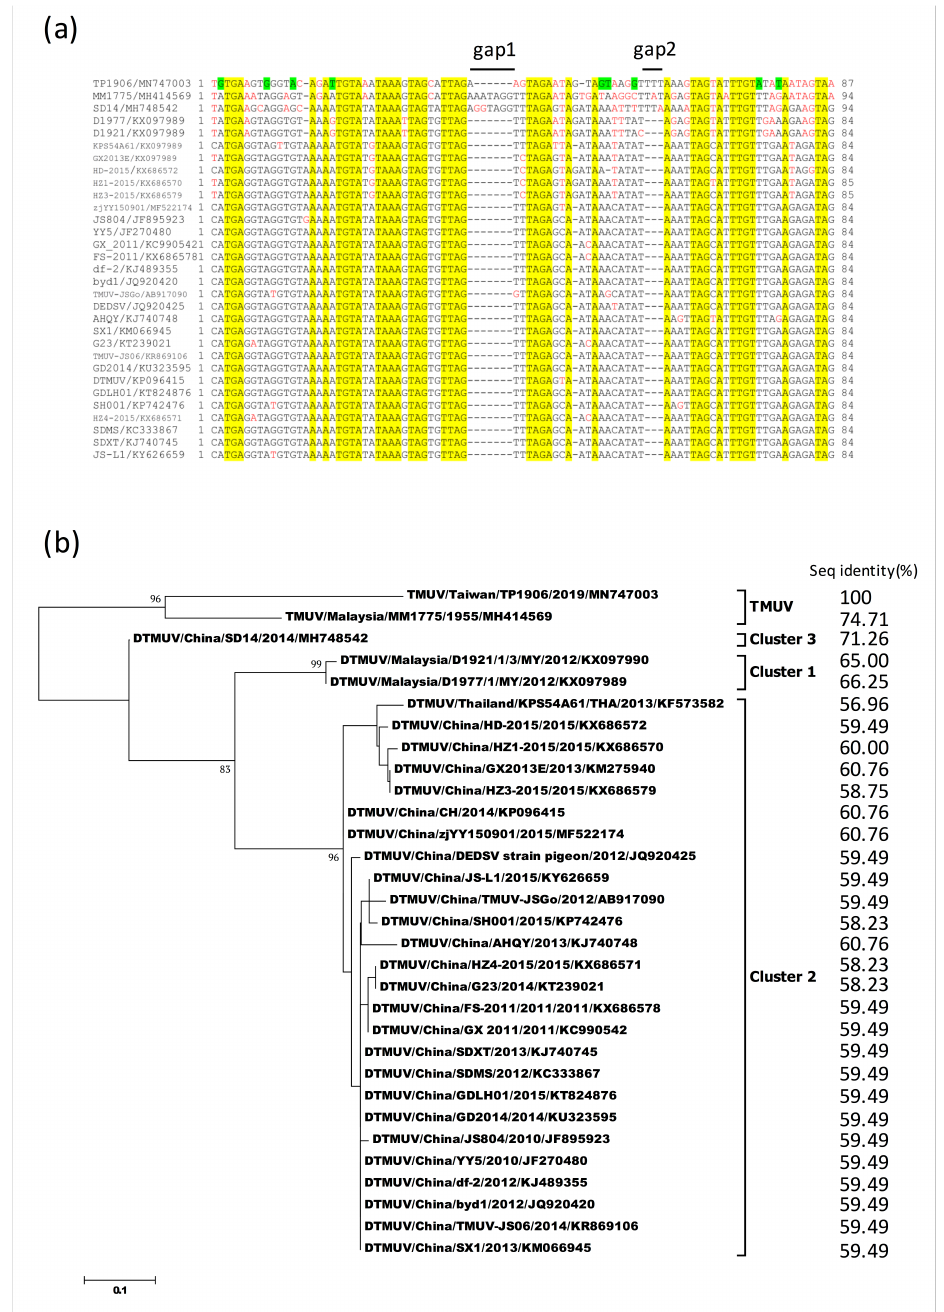
Figure 5. Sequence alignment and phylogenetic tree of 3 (cid:48) UTR variable regions of TMUV-TP1906, Tembusu virus strains (TMUVs), and duck Tembusu virus strains (DTMUVs). ( a ) 3 (cid:48) UTR sequence alignment of TMUV-TP1906, TMUVs, and DTMUVs. The conserved nucleotides are highlighted in yellow and the unique nucleotides of TMUV-TP1906 are highlighted in green. The nucleotides di ff erent from the consensus sequence are colored in red; ( b ) phylogeny of TMUV-TP1906, TMUVs and DTMUVs based on 3 (cid:48) UTR variable region. The evolutionary history was inferred by using the maximum likelihood method based on the Tamura–Nei model. The reliability of the analysis was calculated using 1000 bootstrap replication. Bootstrap support values > 75 are shown. The scale bar indicates amino acid substitutions per site. Sitiawan virus and four DTMUV strains including DK / TH / CU-1, BYD-1, CK-SD-11, and DK / TH / CU-DTMUV which do not deposit the 3 (cid:48) -UTR sequences in GenBank were not